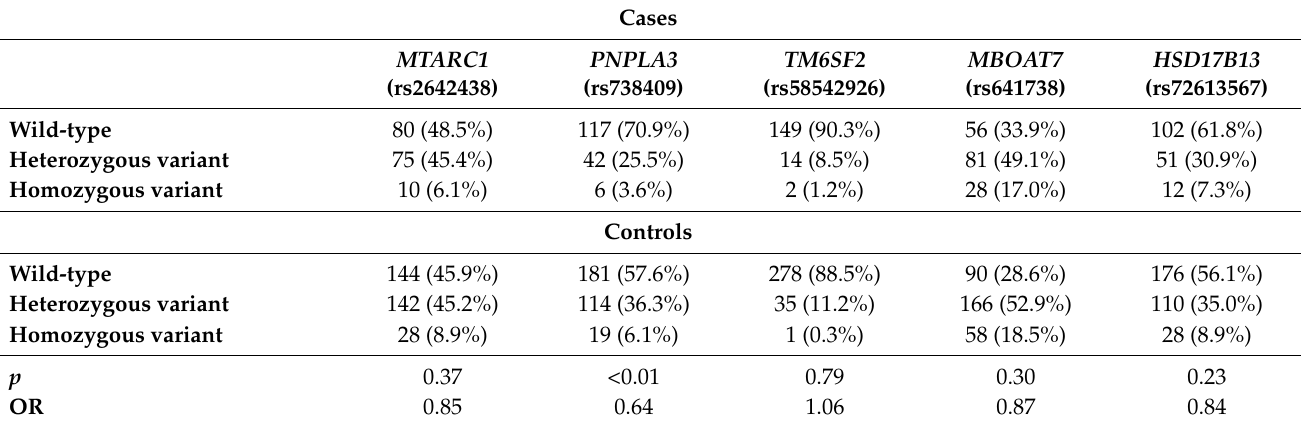
Table 3. Genotype frequencies in all patients scheduled for bariatric surgery (cases) and in controls.